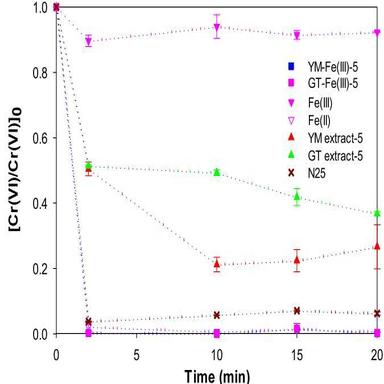
Temporal evolution of normalized Cr(VI) concentration after 20 min of contact with YM-Fe(III)-5, GT-Fe(III)-5, N25 and controls with Fe(III) and Fe(II) at Cr(VI):Fe MR = 1:3, and with YM extract-5 and GT extract-5. Conditions: 0 = 300 μM, pH 3.